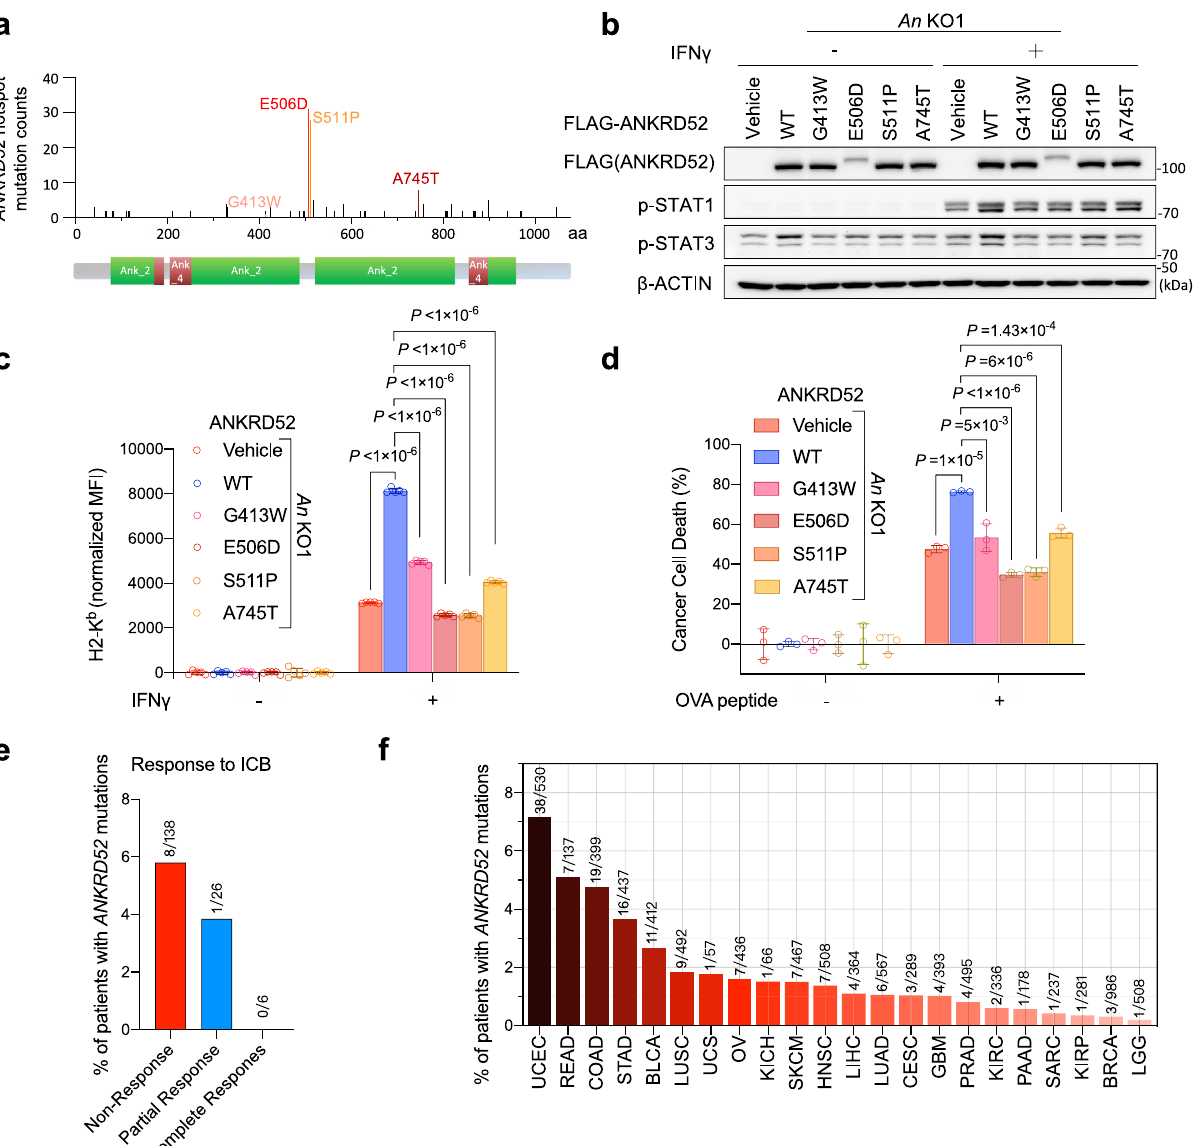
Fig. 5 Hotspot ANKRD52 mutations in patients impair IFN γ and T cell response. a Localization of clinical hotspot ANKRD52 mutations from combined COSMIC and OncoWuXi database. b Protein abundance of p-STAT1 and p-STAT3 in Ankrd52 -null MC38 cells expressing WT or indicated mutant ANKRD52 after IFN γ treatment. Data are representative of two independent experiments. c Membrane MHC-I level in Ankrd52 -null MC38 cells expressing WT or indicated mutant ANKRD52 after IFN γ treatment. MFI of H2-K b was normalized by the responding group without IFN γ treatment ( n = 5 per group per condition). Data are representative of two independent experiments and represented as mean ± s.d., signi fi cance was determined using two-tailed unpaired Student ’ s t -test. d Killing of OVA-treated Ankrd52 -null MC38 cells expressing WT or mutant ANKRD52 by OT-I T cells ( n = 3 per group per condition). Data are representative of two independent experiments and represented as mean ± s.d., signi fi cance was determined using two-tailed unpaired Student ’ s t -test. e Bar plot showing the percentage of patients with mutations in ANKRD52 across cancer patients receiving ICB therapies (anti-CTLA-4 or anti-PD-1) reported by Van Allen et al., Science 2015 and Riaz et al., Cell 2017. The non-response group is composed of SD and PD. f Bar plot showing the percentage of patients with mutations in ANKRD52 across multiple cancer types. Source data are provided as a source data fi immunotherapies 46,47 revealed a higher ANKRD52 mutation rate in tumor samples from non-responders than responders (Fig. 5e).